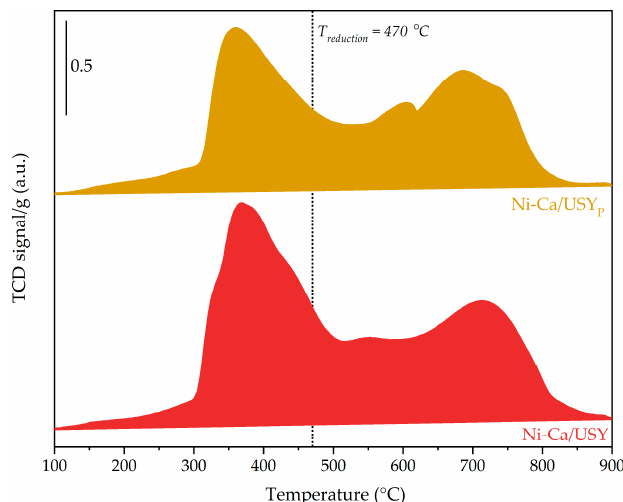
Figure 9. H 2 -TPR profiles obtained for Ni-Ca/USY and Ni-Ca/USY P catalysts.